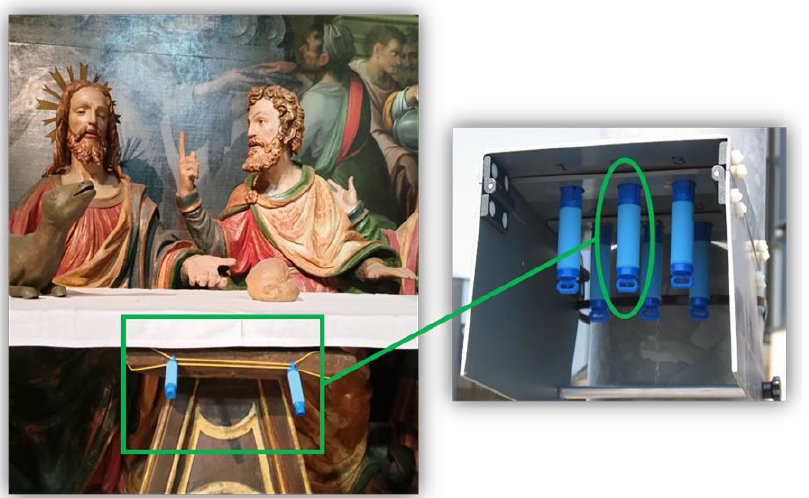
Figure 13. Diffusive passive samplers positioned in one of the main chapels close to the sculptural group of the Last Supper .